Question: Provide a one-line summary of what is displayed.
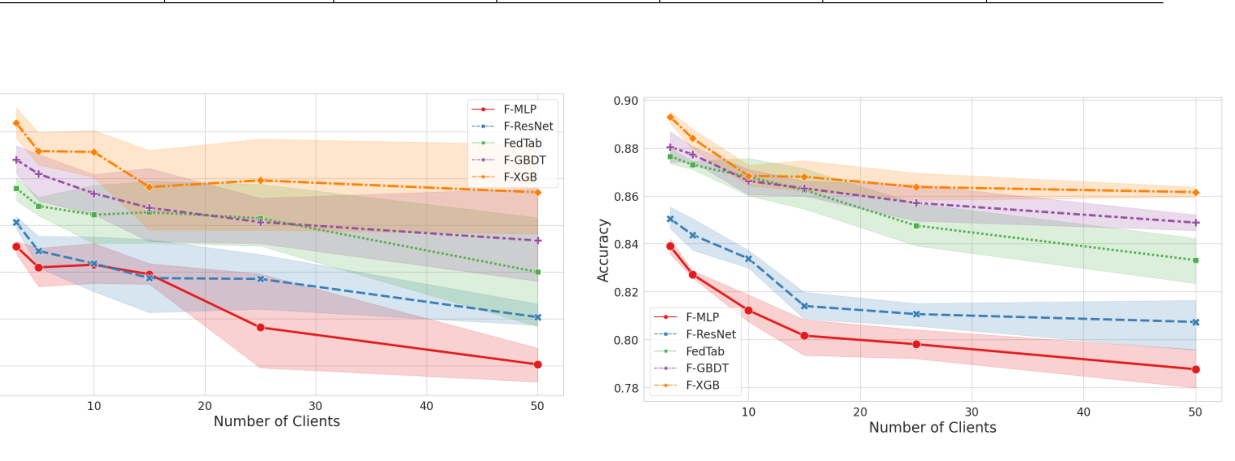
Answer: Models’ test accuracy for 3, 5, 10, 15, 25 and 50 clients on Synthetic dataset in homogeneous setting.